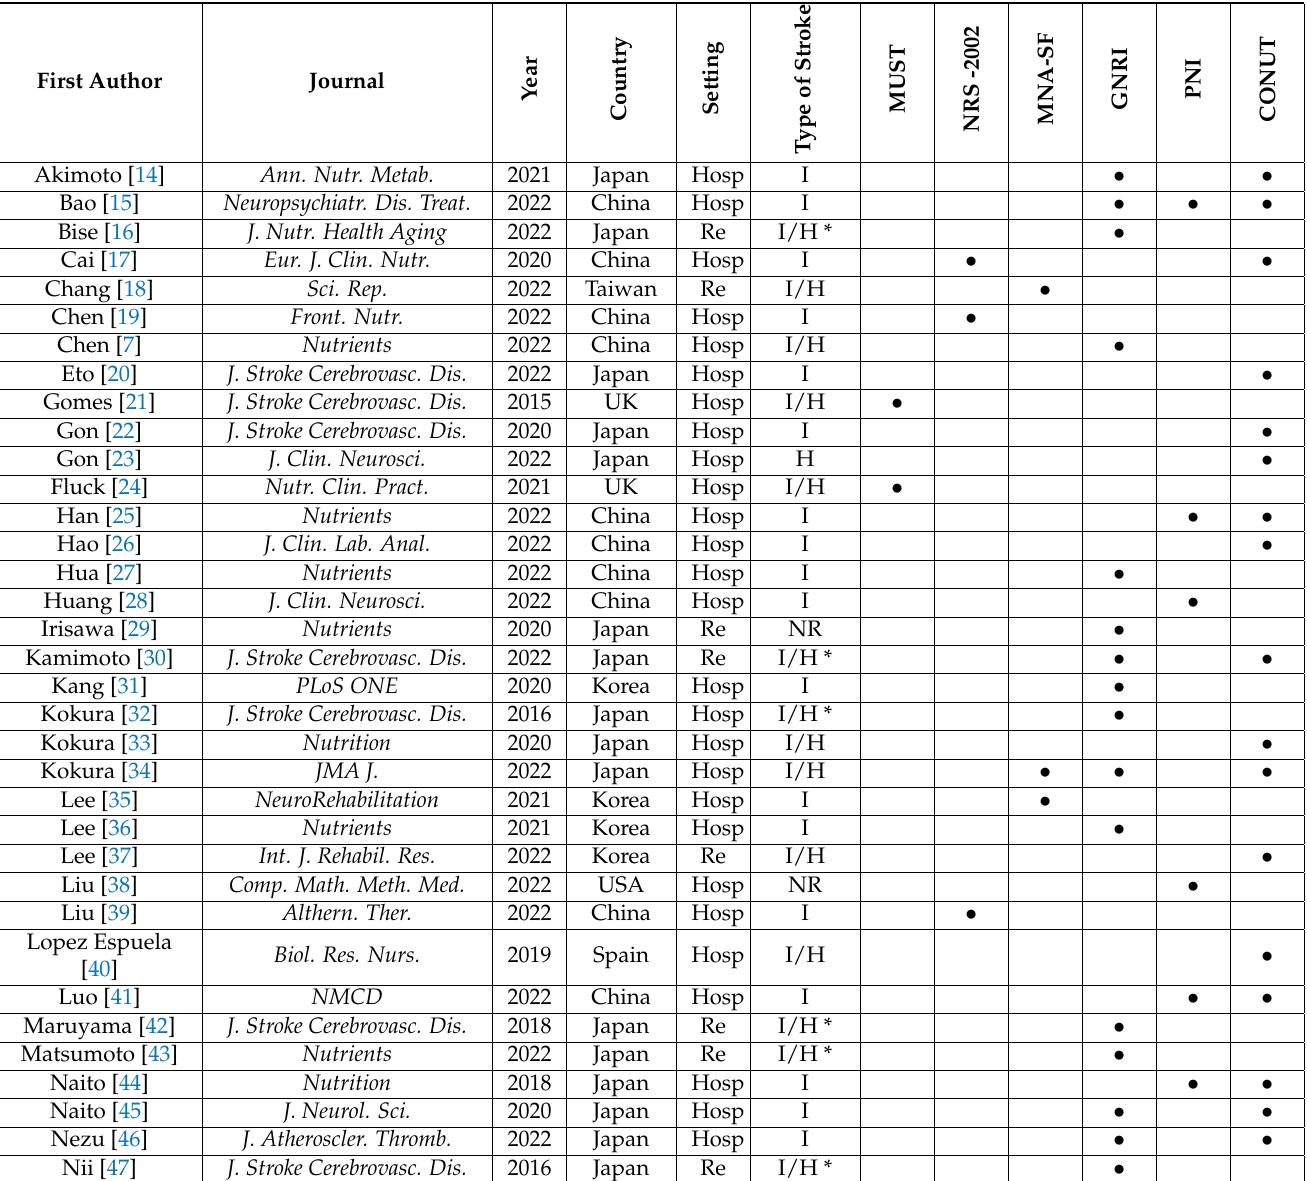
Table 1. Papers evaluating nutritional risk among stroke patients with the corresponding screening tools used in each study (continued on next